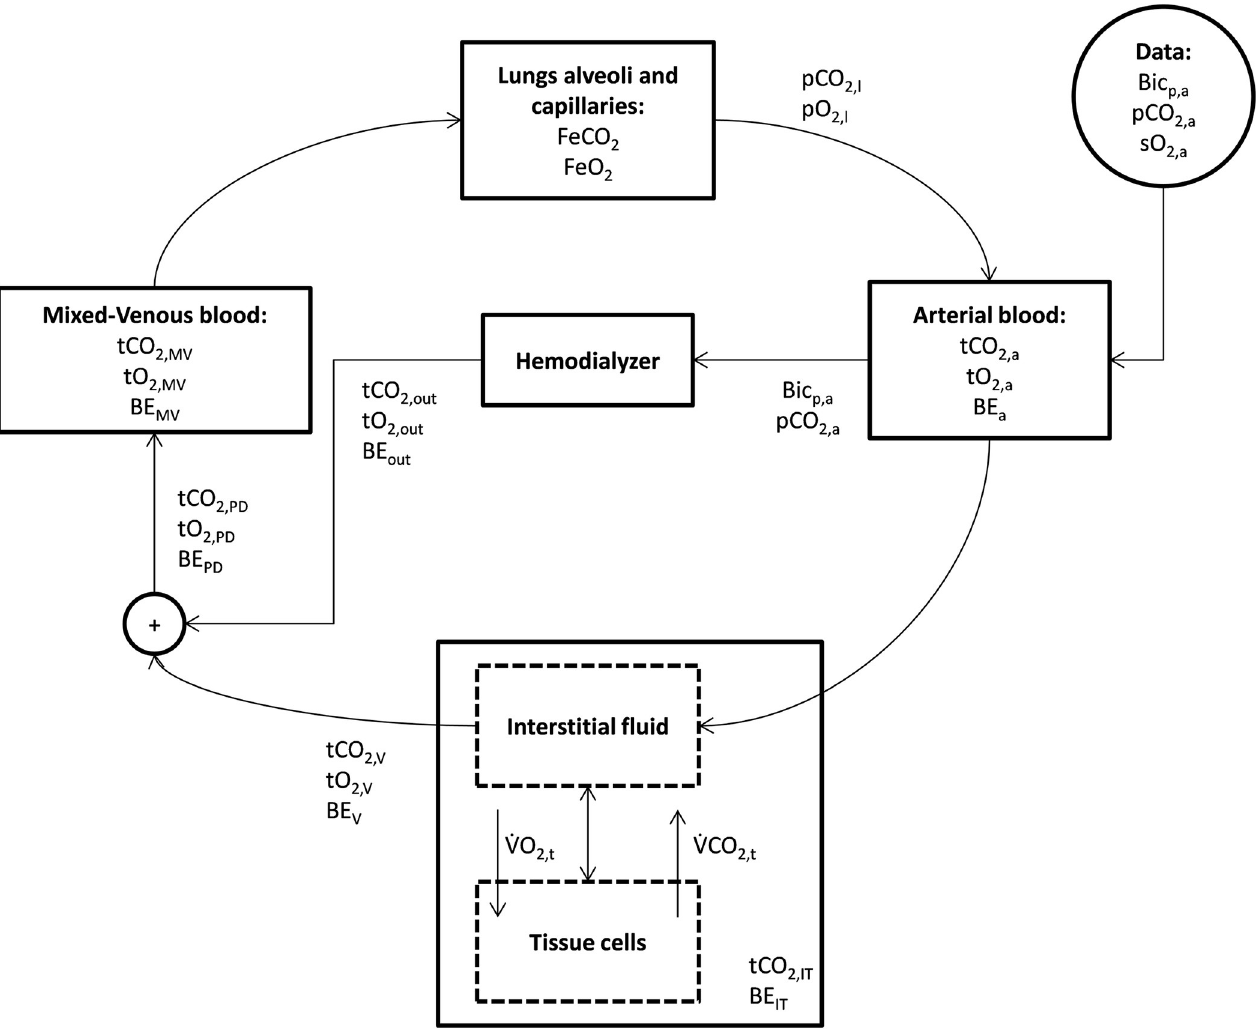
Fig 1. General structure of the modified model of transport of carbon dioxide and oxygen in the human body, summarizing the input and outputs of the model compartments. The state variables are reported for each of the four main compartments, and their value is calculated by solving the blood chemistry system of equations using the inputs for each compartment. See Appendix D in S1 Text for the explanation of the